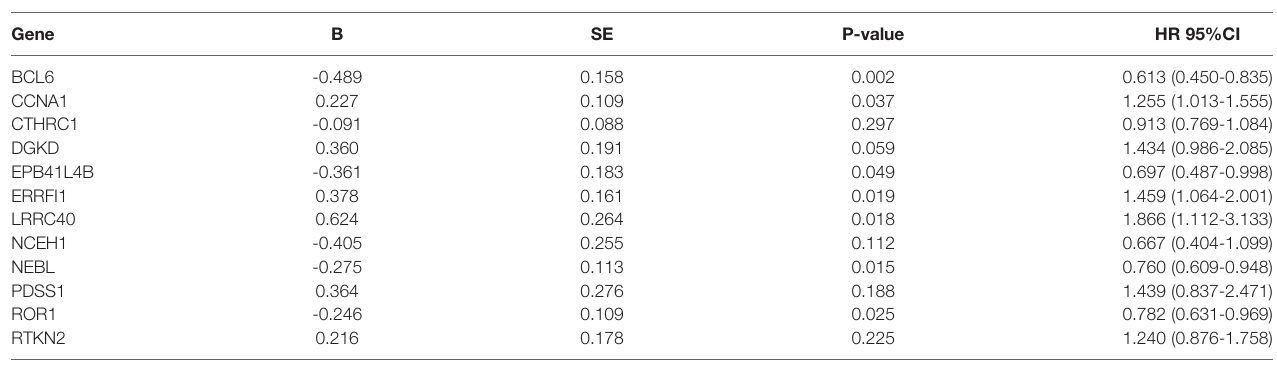
TABLE 2 | Univariate cox analysis of 12 genes.